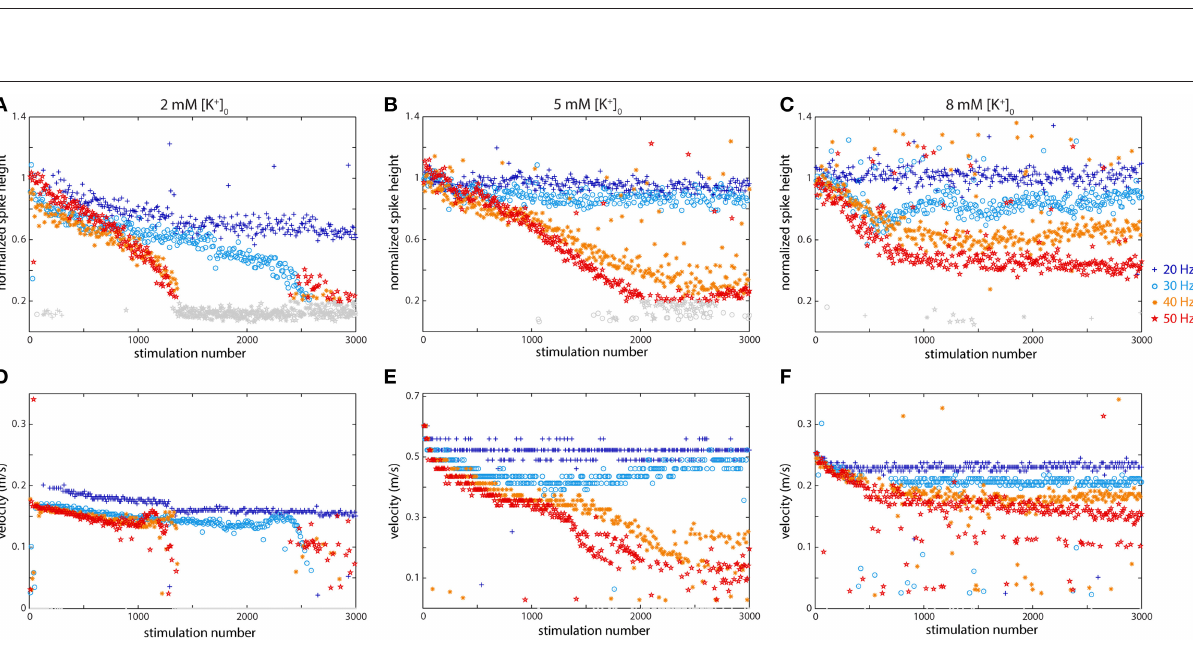
Frontiers in Neuroscience | www.frontiersin.org